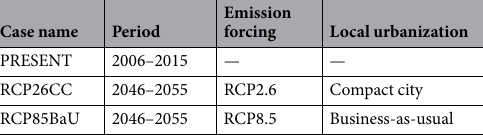
Table 1. Simulation